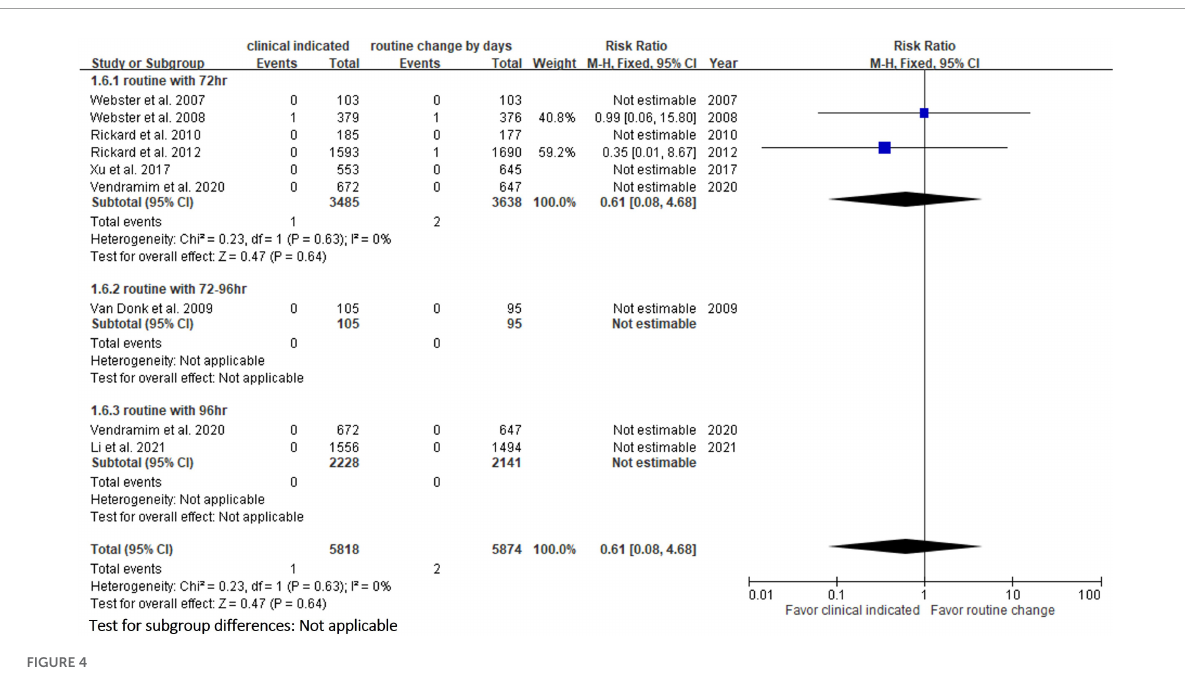
FIGURE4 Forest plot of the risk of